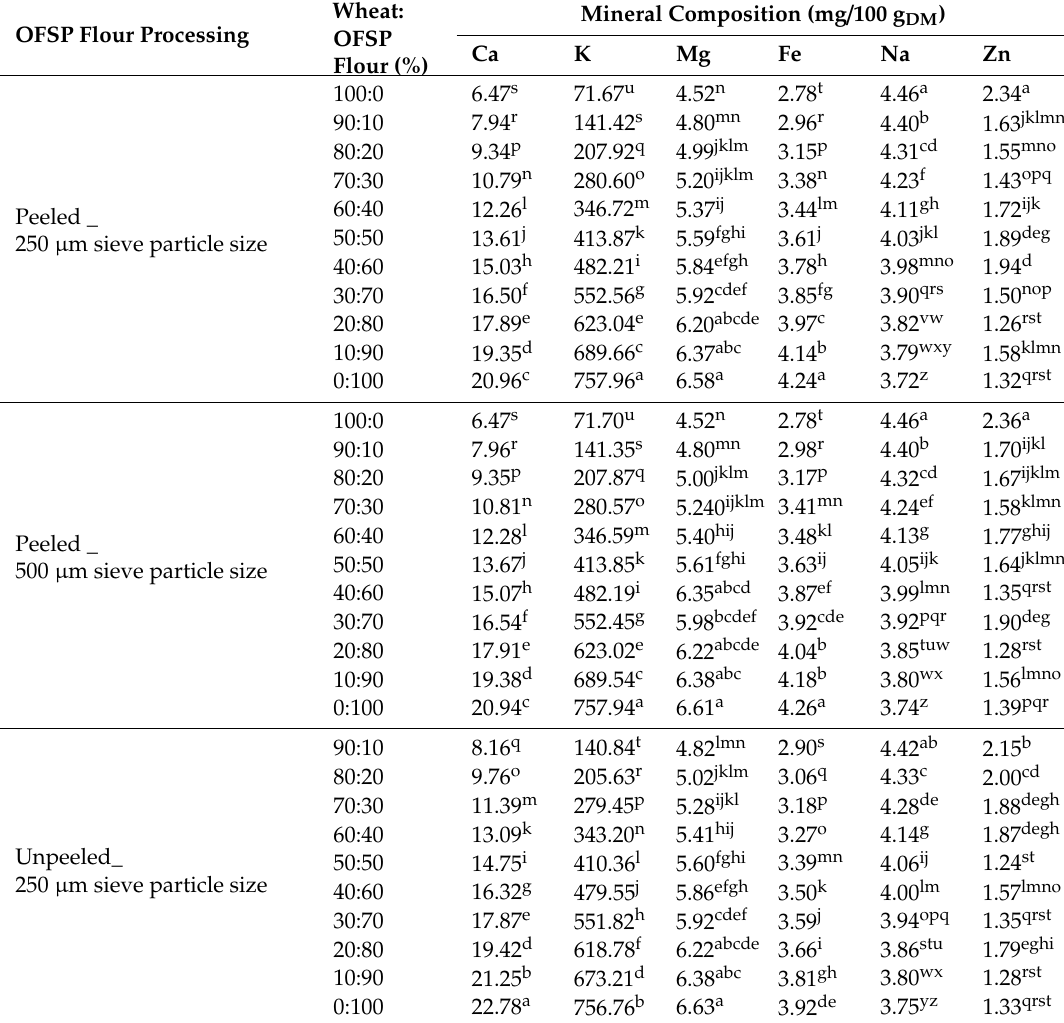
Table 2. E ff ect of sieve particle size and blend proportion on mineral composition of peeled and unpeeled OFSP composite flours. Wheat: Mineral Composition (mg / 100 g DM OFSP Flour Processing OFSP Flour (%)